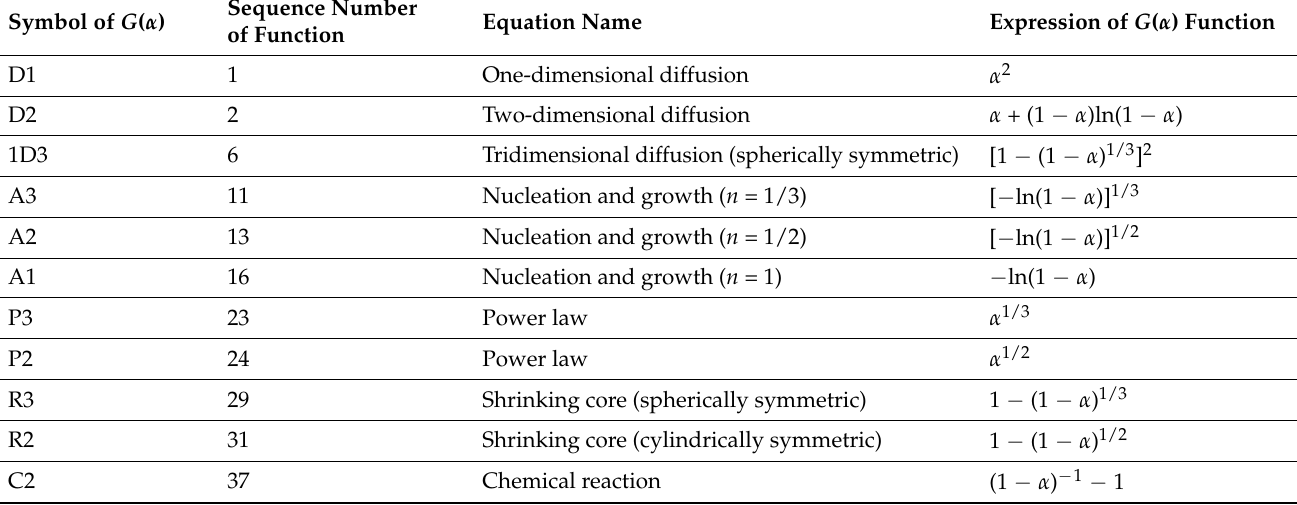
Table 2. Common mechanism functions of G ( α ) for solid-state reactions